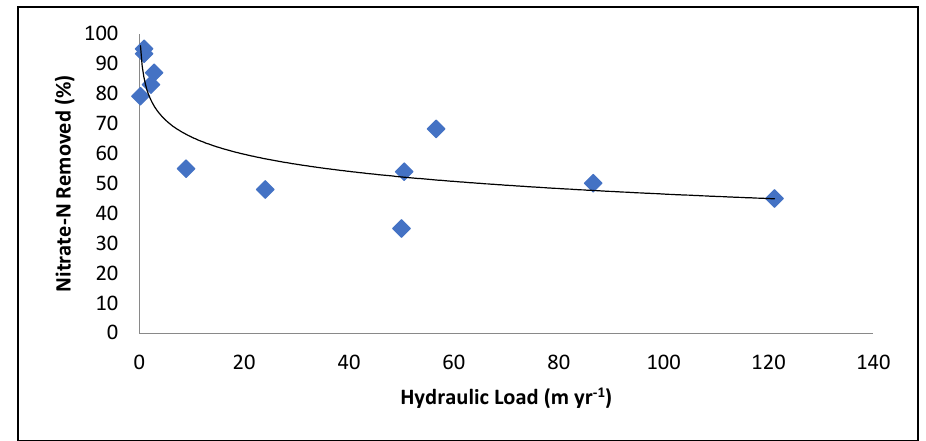
Figure 3. Relationship between the hydraulic load entering each floodplain and nitrate-N (NO 3 − -N) mass removed (y = 5.6568x + 79.61, ρ = 0.79, p = 0.004).